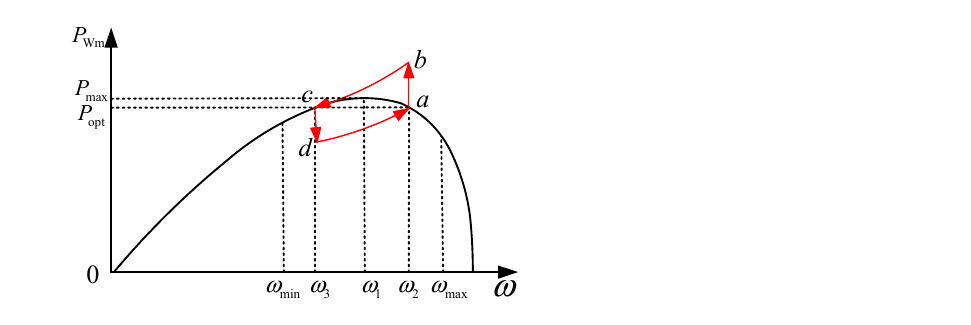
Figure 4. Schematic diagram of frequency regulation process of DFIG under overspeed control.